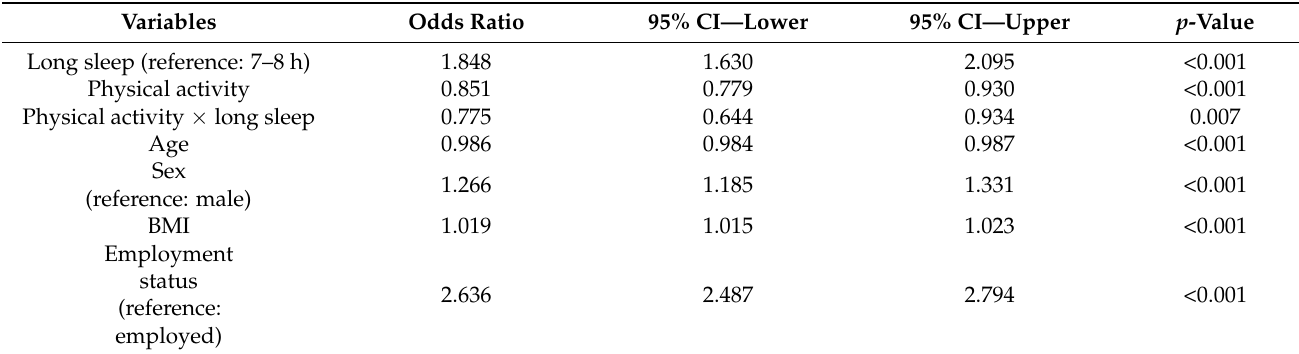
Table 13. The moderating effect of physical activity on the relationship between long sleep and emotional distress predictions among Blacks ( n =